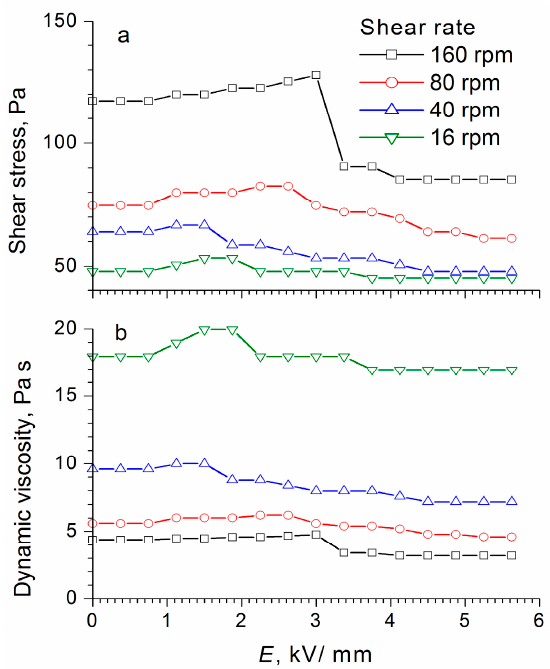
Figure 10. Dependence of ( a ) shear stress and ( b ) dynamic viscosity of the electrorheological fluid containing 60 wt% WO 3 /DDA on the electric field strength, at different shear rates.